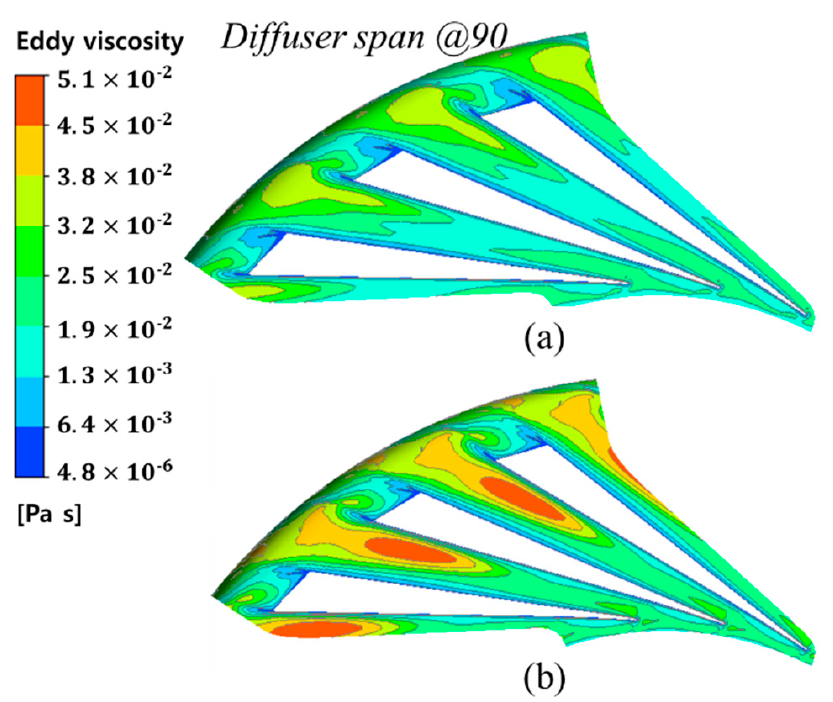
Figure 17. Diffuser eddy viscosity distribution between the ( a ) dry and ( b ) wet compression at the stall region .